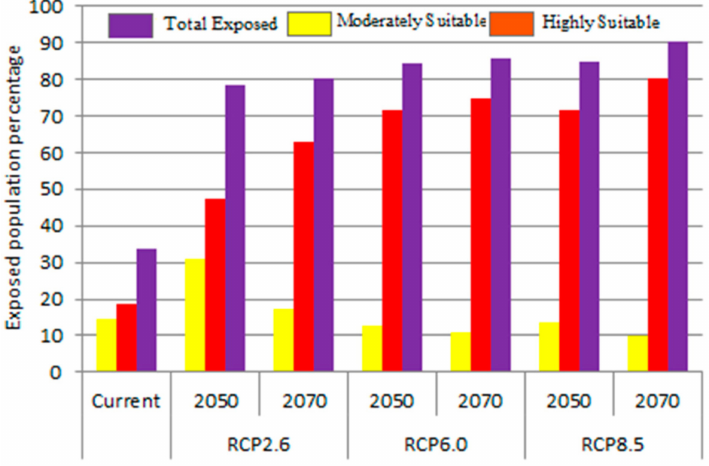
Figure 7. Proportion of human population under the risk of dengue fever in the present and future. The yellow bar reprsents the human population exposed to a moderately suitable area, the red bar to the highly suitable area and the magenta bar represents the total human